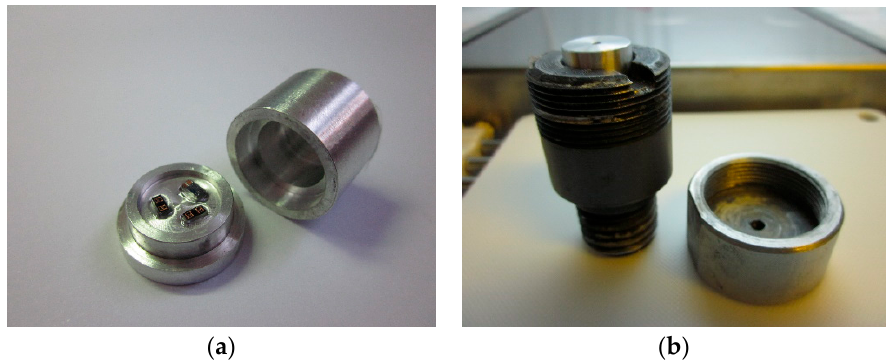
Figure 9. The test shell and the test fixture. ( a ) The shell before assembly. ( b ) The test fixture with the shell.